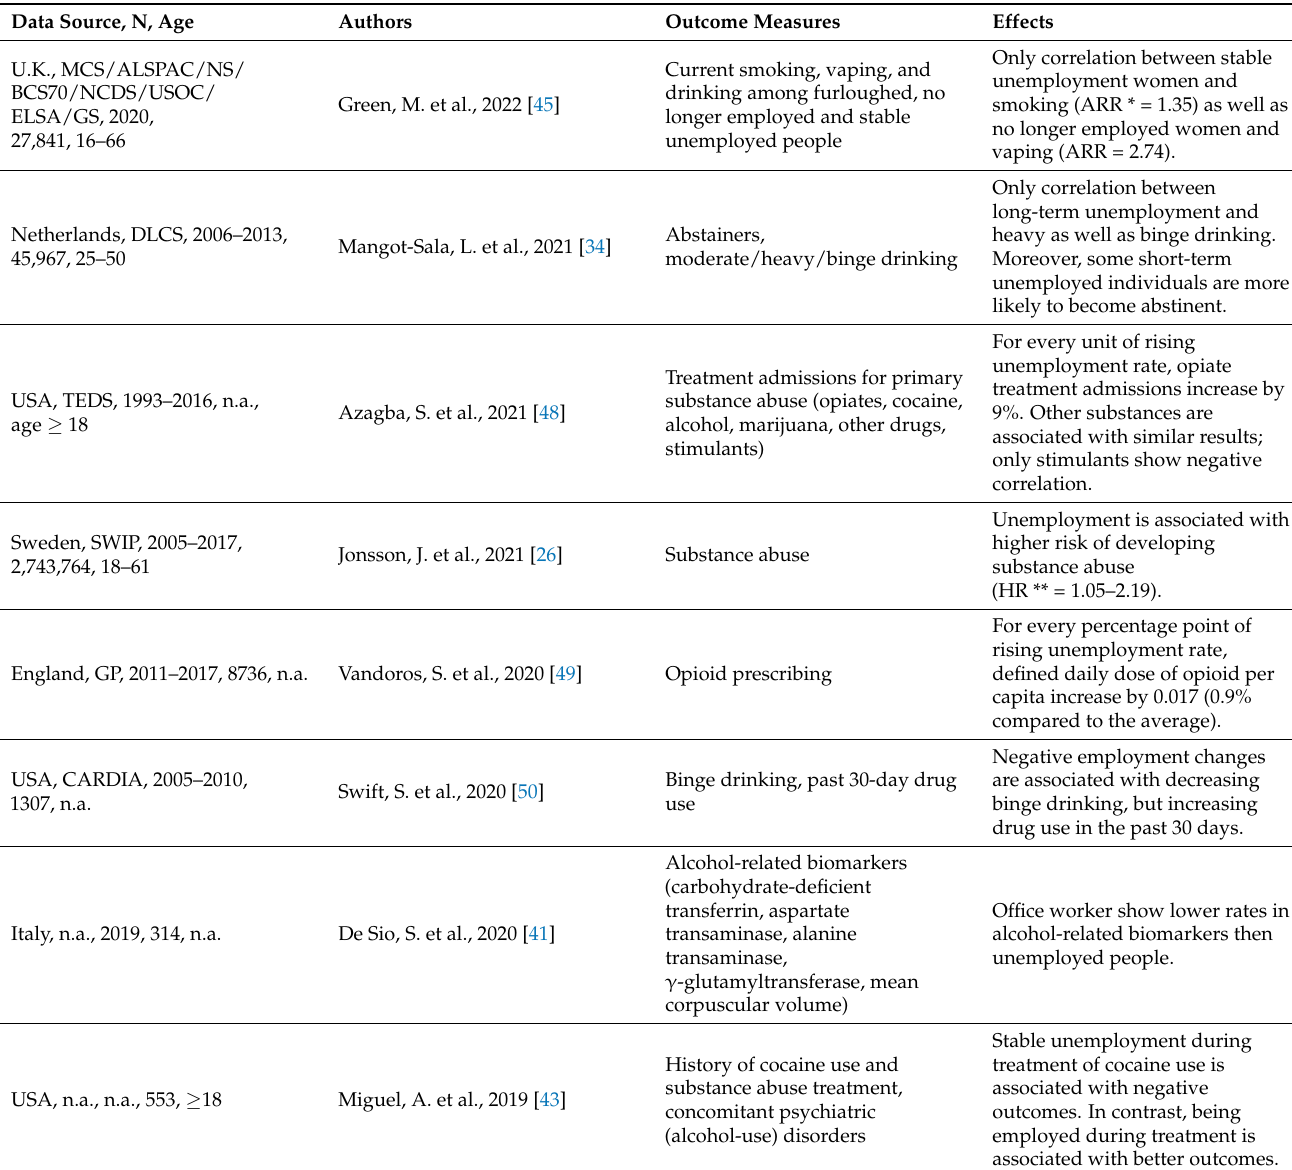
Table 3. Effects of Job Loss/Unemployment on Substance-Use